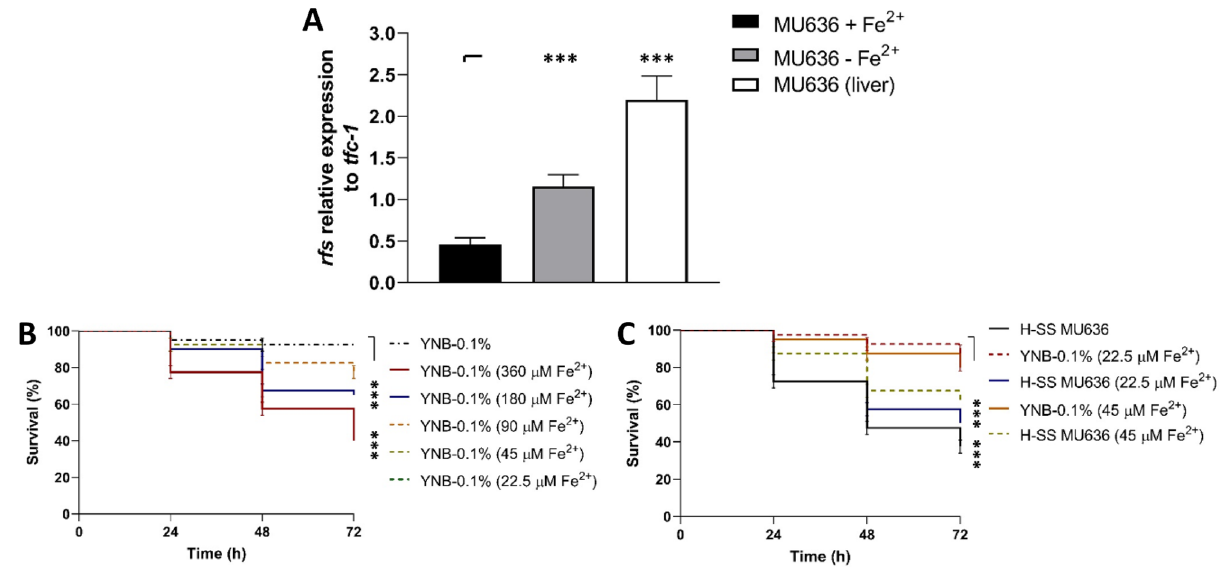
Figure 3. Addition of Fe 2+ downregulates rfs expression and negatively influences the virulence of the cell- free supernatant of the culture (SS) from M. lusitanicus . ( A ) Quantification of the mRNA levels of rfs in the mycelium of MU636 grown for 48 h under aerobic conditions in Vogel´s medium supplemented with 2% glucose with or without supplementation with 200 μM Fe 2+ or in the livers of diabetic mice infected previously with 3 × 10 6 spores of the MU636 strain and euthanized 7 days post infection; a ∆Ct analysis was performed to compare the mRNA levels between samples. tfc1 was used as reference housekeeping gene ( B ) Effect of Fe 2+ present at different concentrations in the YNB medium with 0.1% glucose (YNB-0.1%) on nematode survival. ( C ) Toxicity of the SSs obtained when the fungus (strain MU636) was aerobically grown (H-SS) for 48 h in YNB-0.1% supplemented with 22.5 μM or 45 μM Fe 2+ . All the SSs were used to treat Caenorhabditis elegans . A total of 15–20 nematodes were used per well and incubated at 18 °C for 72 h. Significance testing was performed using ANOVA with Fisher’s exact test, * P < 0.05; ** P < 0.01; *** P < 0.001. The virulence results presented are the average from four independent experiments. Data were statistically analyzed using the Mantel-Cox test. *** P < 0.01. When results were not considered significant, we did not provide an additional indication ( P > the WT and Δ rfs + rfswt exhibited 25% and 30% lethality, respectively, ∆ rfs caused less than 10% lethality in mice, and the NRRL3631 strain was avirulent in this assay (Fig. 5A), probably because of its delayed germination and higher sensitivity of the cell wall to detergents, as described before 32 . Animals infected with MU636 + rfswt showed the highest loss of weight (≈ 20%) at 7 days post-infection. Animals infected with ∆ rfs exhibited a similar increment in weight as the avirulent strains, followed by those infected with the WT or Δ rfs + rfswt (Fig. 5B). The livers of mice infected with Δ rfs as well as MU402 or NRRL3631 exhibited lower fungal loads than the tissues of animals infected with WT or Δ rfs + rfswt (Fig. 5C). Meanwhile, tissues from animals infected with MU636 + rfswt exhibited the highest fungal loads (Fig. 5C). The livers of mice infected with spores from MU636 + rfswt or its V o fraction (obtained similarly as that in Fig. 2) showed the highest mRNA levels of the inflammation marker IL-6 compared to those of animals infected with spores or their V o fractions from MU636 and Δ rfs + rfswt , whereas Δ rfs induced the lowest levels of mRNA expression of this inflammatory marker (Fig. 5D,E). These results indicated that the deletion of rfs decreased the virulence in diabetic mice and the overexpression of rfs increased the virulence. Macrophage interaction and oxidative stress increased the mRNA levels of rfs and production of rhizoferrin. After interaction with the mouse RAW267.4 monocytes/macrophage cell line for 3 h, both WT (R7B and MU636) strains showed higher levels of rfs mRNA production (71%–88%) than strains without macrophage interaction (Fig. 6A). To determine the effect of oxidative stress on the virulence, MU636 was incubated in YPG-2% in the presence of different concentrations of H 2 O 2 for 1 h, following which the cells were washed and transferred to fresh YPG-2% for 48 h (without H 2 O 2 ), and finally, the SS was obtained to evaluate its toxicity in nematodes. In contrast to the SS obtained from the H 2 O 2 -untreated culture, that obtained after incu- bation with the peroxide showed greater toxicity at all concentrations of H 2 O 2 tested (Fig. 6B). The rfs mRNA levels were higher (≈ 50%) in mycelium grown under H 2 O 2 -induced oxidative stress than in cultures without H 2 O 2 (Fig. 6C). Further, the mRNA levels of the mitochondrial marker atp9 increased by ≈38% in the presence of H 2 O 2 ; in contrast, the transcript levels of adh1 , which indirectly reflects the fermentation state, did not change under this treatment (Fig. 6C). Oxidative stress also positively influenced the accumulation of the transcripts of citrate synthase ( cit1 ) and ornithine decarboxylase ( spe1 ), which synthesize the substrates used by Rfs (Fig. 6D). Under oxidative stress, rhizoferrin production increased by two-folds at any time point when assayed in the presence of H 2 O 2 compared to that in YNB-0.1% not supplemented with H 2 O 2 . Either in the presence or absence